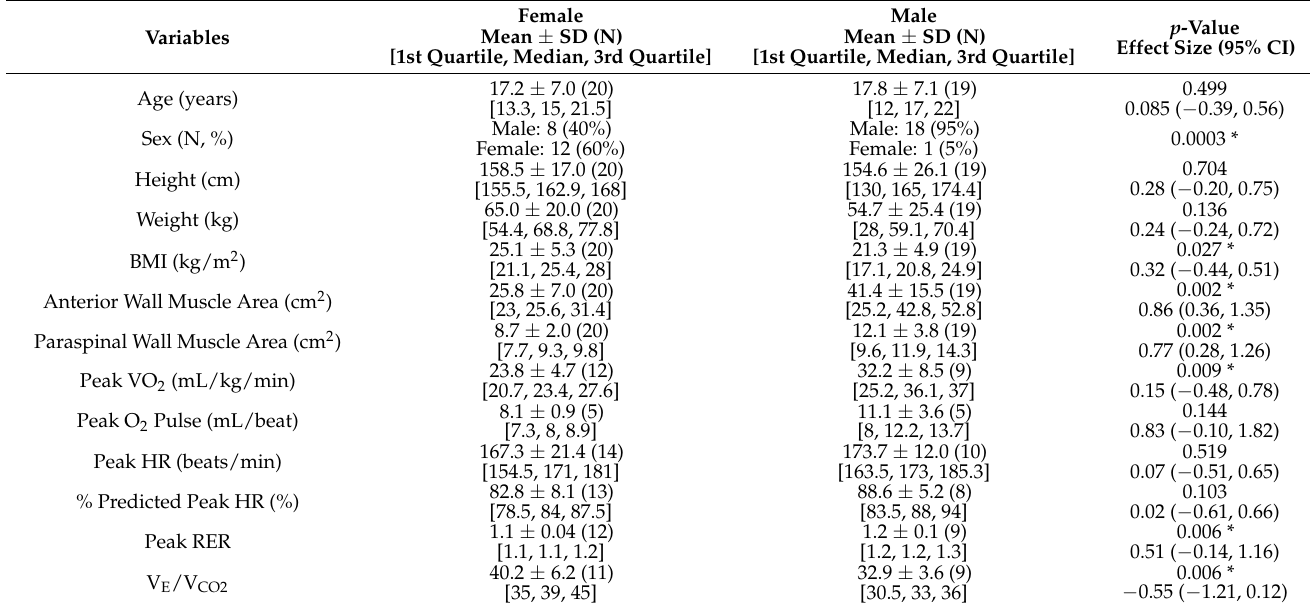
Table 3. Sex-specific characteristics. T -testing was used for sample sizes >30, for those <30, Mann– Whitney U was used. Effect sizes were calculated by using Cohen’s d test for groups with similar sample sizes or sample sizes > 20. Hedges’ g test was used to calculate effect size for groups with largely different sample sizes or sizes <